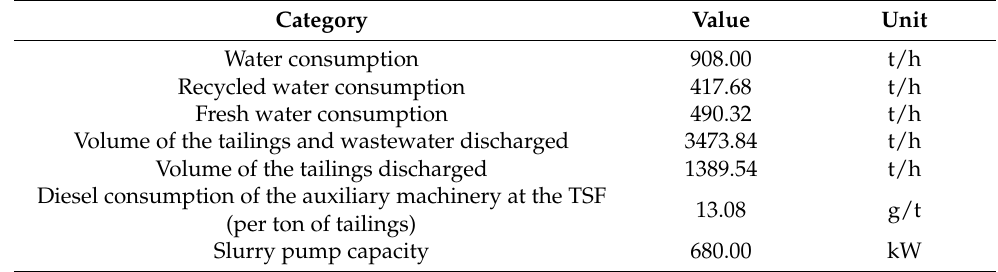
Table 1. CSDT scheme LCA data.